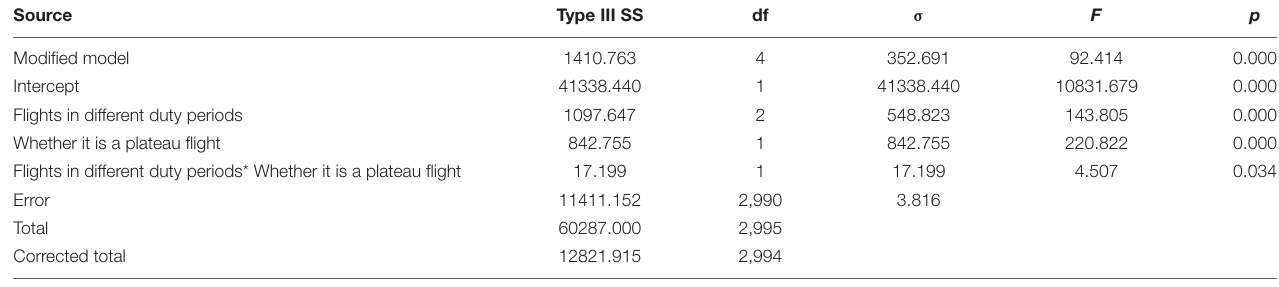
TABLE 9 | Table of linear regression